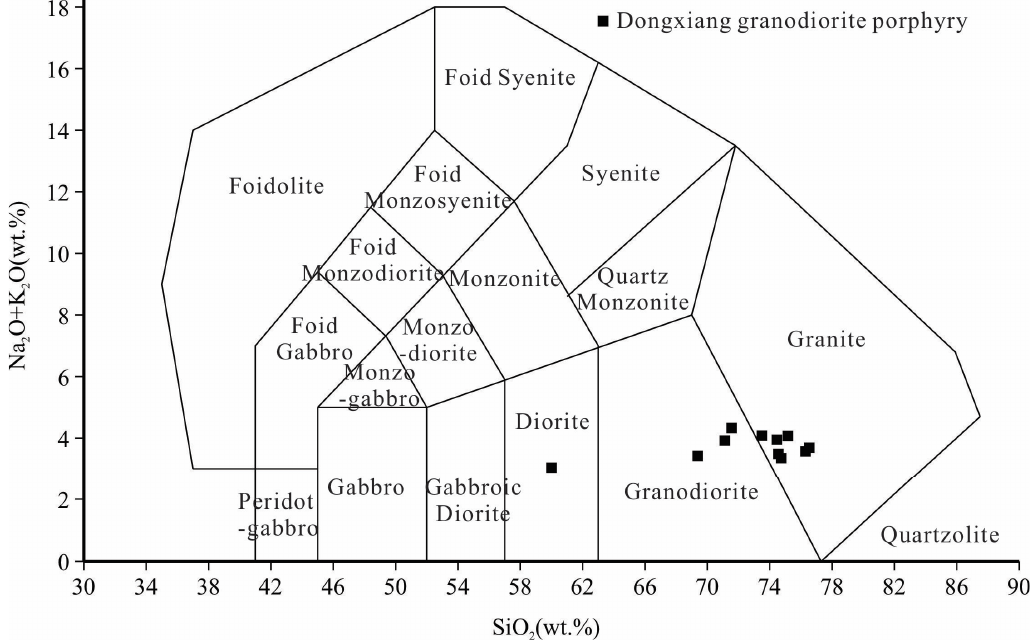
Figure 3. Total alkali vs. silica (TAS) diagram (adapted from Winchester and Floyd, 1977) for the Dongxiang granodiorite porphyry [41].